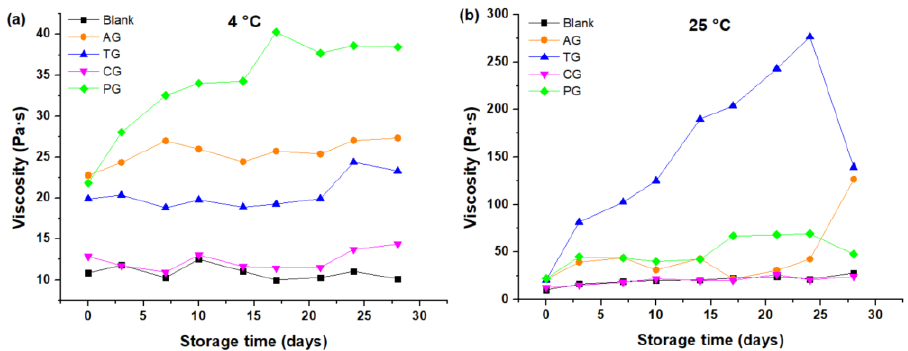
Figure 1. Viscosity as a function of storage time: ( a ) Creams stored at 4 ◦ C; ( b ) Creams stored at 25 ◦ C. The (cid:36) increased with storage time both at 4 ◦ C and at 25 ◦ C. In this sense, creams made